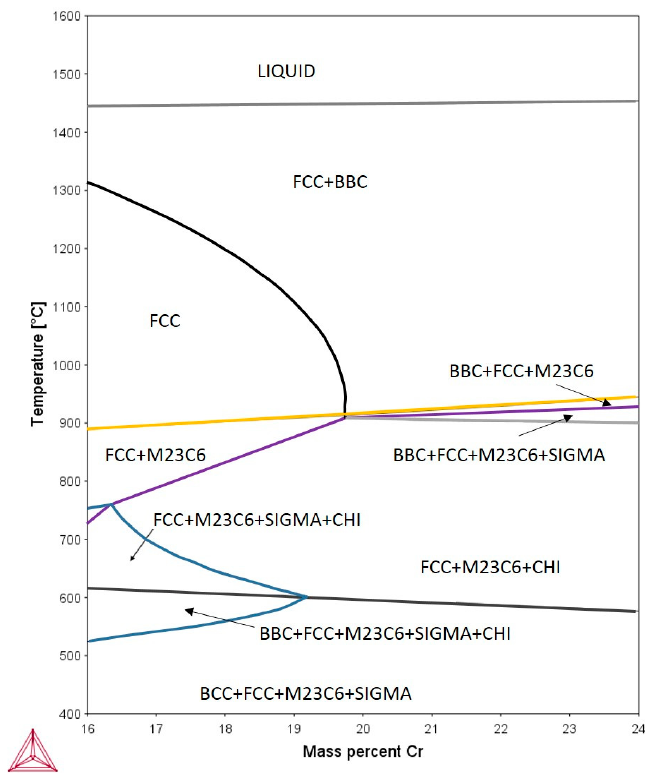
Figure 1. Vertical section of the phase diagram predicted for the Fe-(16-24)Cr-0.023C-0.75Si-1.52Mn-10.8Ni-2.62Mo-0.017S system.